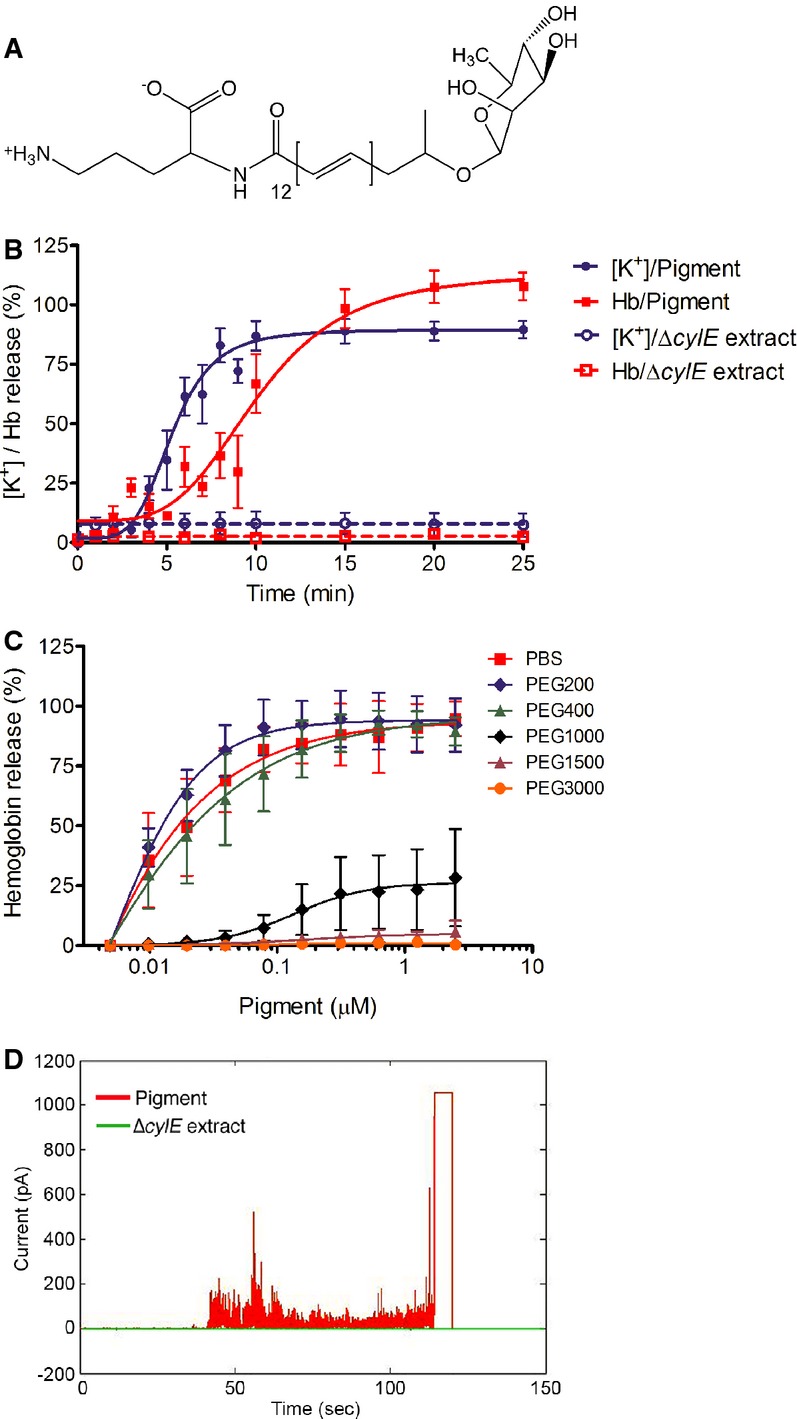
Colloidal osmotic lysis and membrane permeabilization caused by the GBS pigment/lipid toxin
The GBS pigment also known as granadaene is an ornithine rhamnopolyene (Rosa-Fraile et al, 2006).

Human red blood cells (RBCs) were incubated with 400 nM pigment or control ΔcylE extract, and kinetics of K+ and Hb release was monitored. Data shown are the average and SEM of six independent experiments. The time to 50% K+ and 50% Hb release with pigment was 4.8 min and 8.4 min, respectively; n = 6, P < 0.0001, extra sum-of-squares F test.

Role of osmoprotectants in pigment-treated RBC. Human RBCs were pre-incubated with GBS pigment for 2 min at RT, centrifuged, and resuspended in the presence and absence of 30 mM osmoprotectant with hydrodynamic radius of 0.40 nm (PEG200), 0.56 nm (PEG400), 0.89 nm (PEG1000), 1.1 nm (PEG1500), or 1.6 nm (PEG3000), respectively. Release of Hb was measured after 1 h of incubation at 37°C. Data shown are the average and SEM of three independent experiments.

Characteristics of membrane permeabilization by the GBS pigment in artificial lipid bilayers. Lipid bilayers were generated using diphytanoylphosphatidylcholine (DPhPC) and treated with either 2 μM pigment or an equivalent amount of the control ΔcylE extract. In the pigment-treated sample, channel conductance indicating disruption of the membrane is seen within 45 s. Erratic and non-discrete fluctuations in current are observed, suggesting the formation of multiple, small membrane defects. The bilayer eventually breaks at 120 s. In lipid bilayers treated with the control ΔcylE extract, the mean ionic current trace remains constant at 0 pA, showing no membrane disruption. Data shown are representative of three independent experiments.